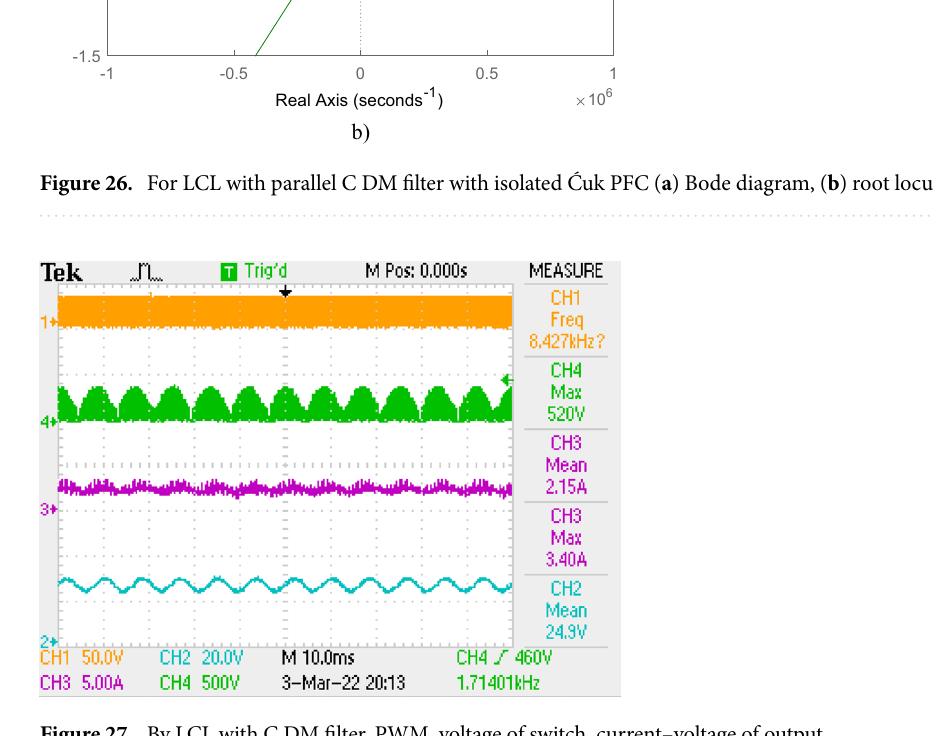
Figure 27. By LCL with C DM filter, PWM, voltage of switch, current–voltage of